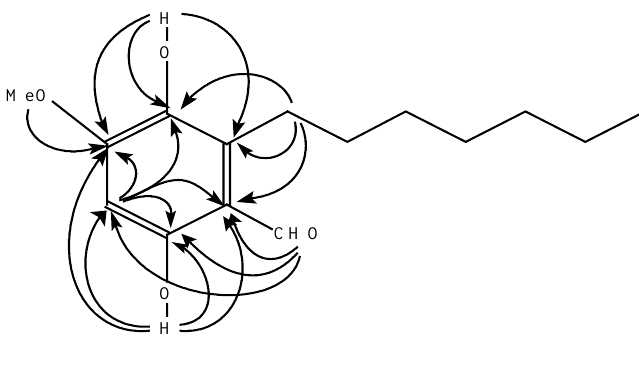
Figure 2 . Important HMBC correlations of ( 1 ).